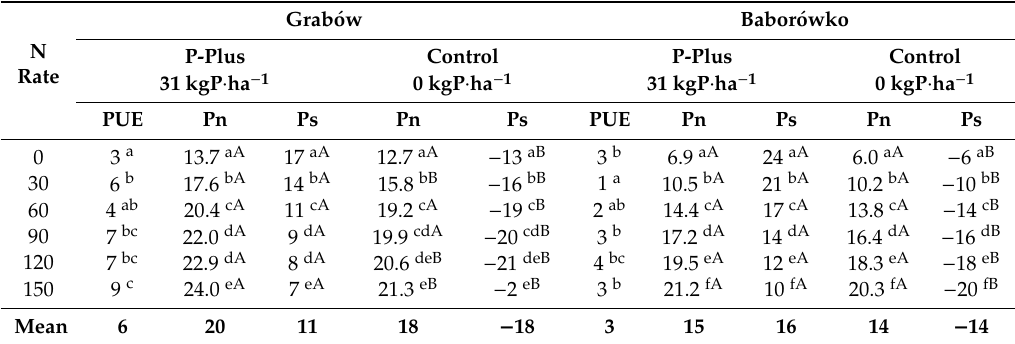
Treatments with the same letter are not significantly di ff erent ( p ≤ 0.05). The capital letters denote di ff erences between Pn, Ps in P-plus and control treatments and the small letters denote di ff erence between N rates; n = 320 for